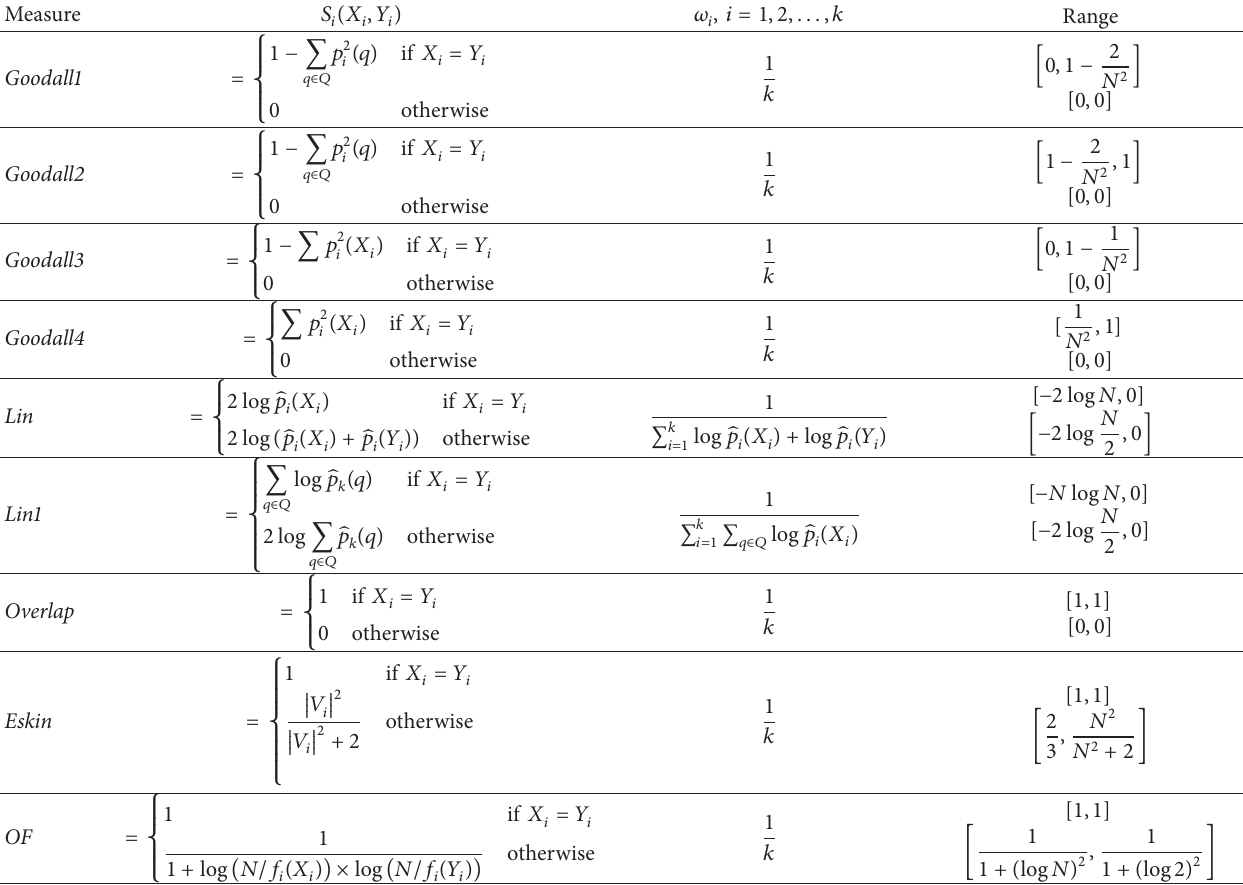
Table 2: Similarity measures for categorical parameter